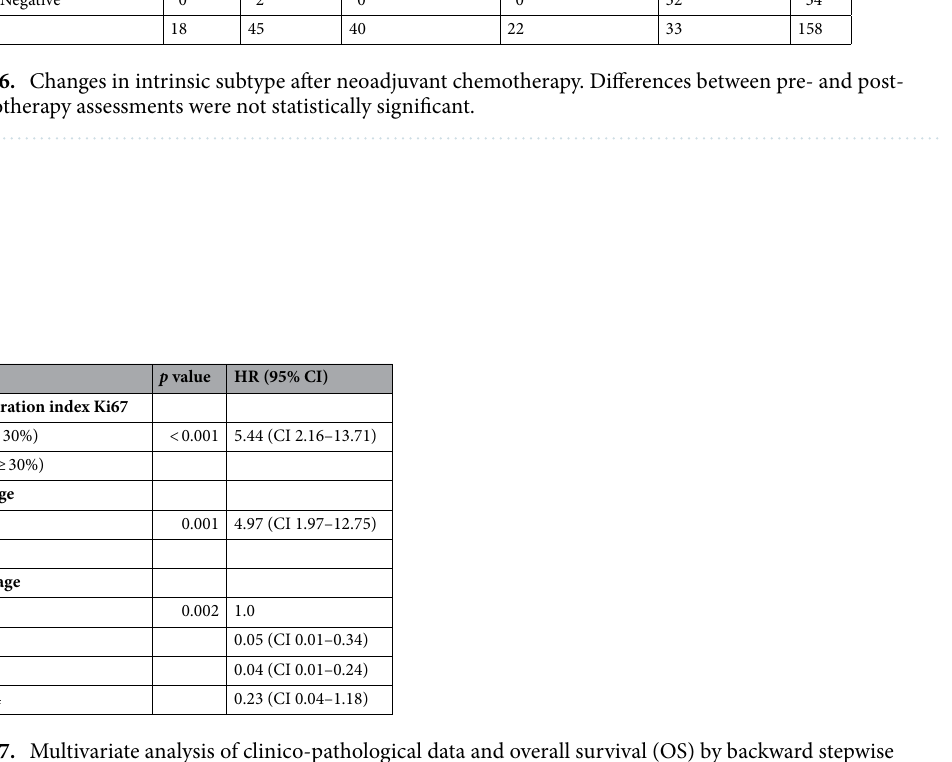
Table 7. Multivariate analysis of clinico-pathological data and overall survival (OS) by backward stepwise variable selection (significant results